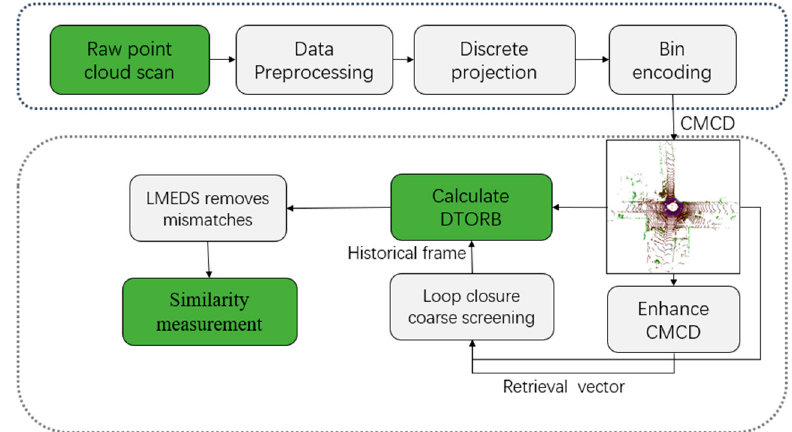
Figure 2. System overview.